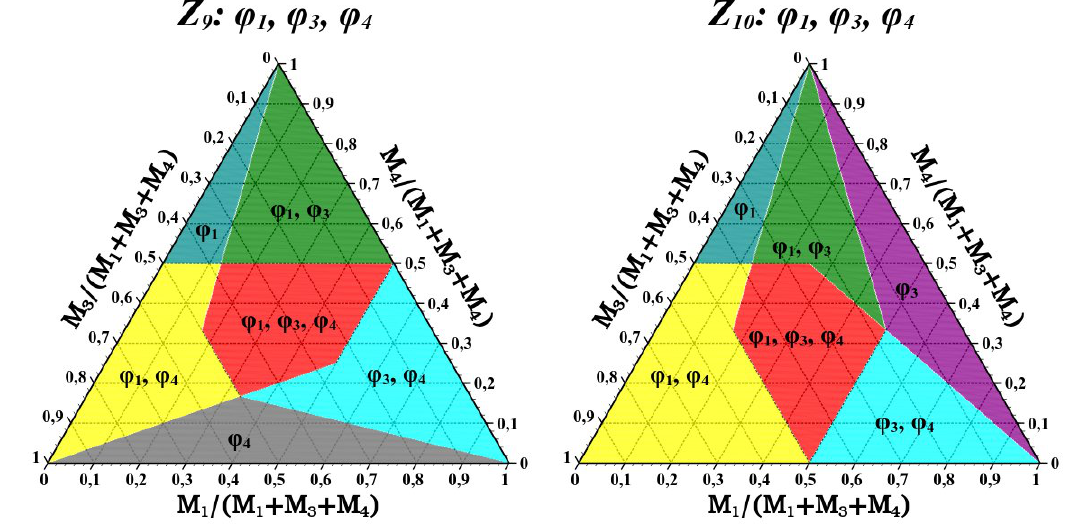
Figure 4 . Stability regions for a Z 9 (left panel) and Z 10 (right panel) symmetry with (cid:12)elds (cid:30) 1 ; (cid:30) 3 ; (cid:30) 4 . (red region). That (cid:12)gure also displays the regions with one- or two-component dark